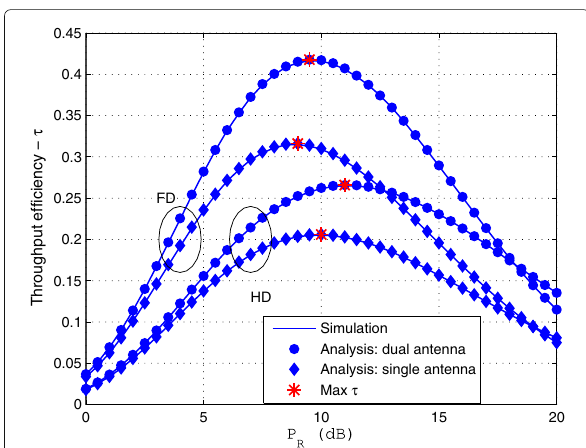
Fig. 6 Throughput efficiency versus σ 2 D with m f =